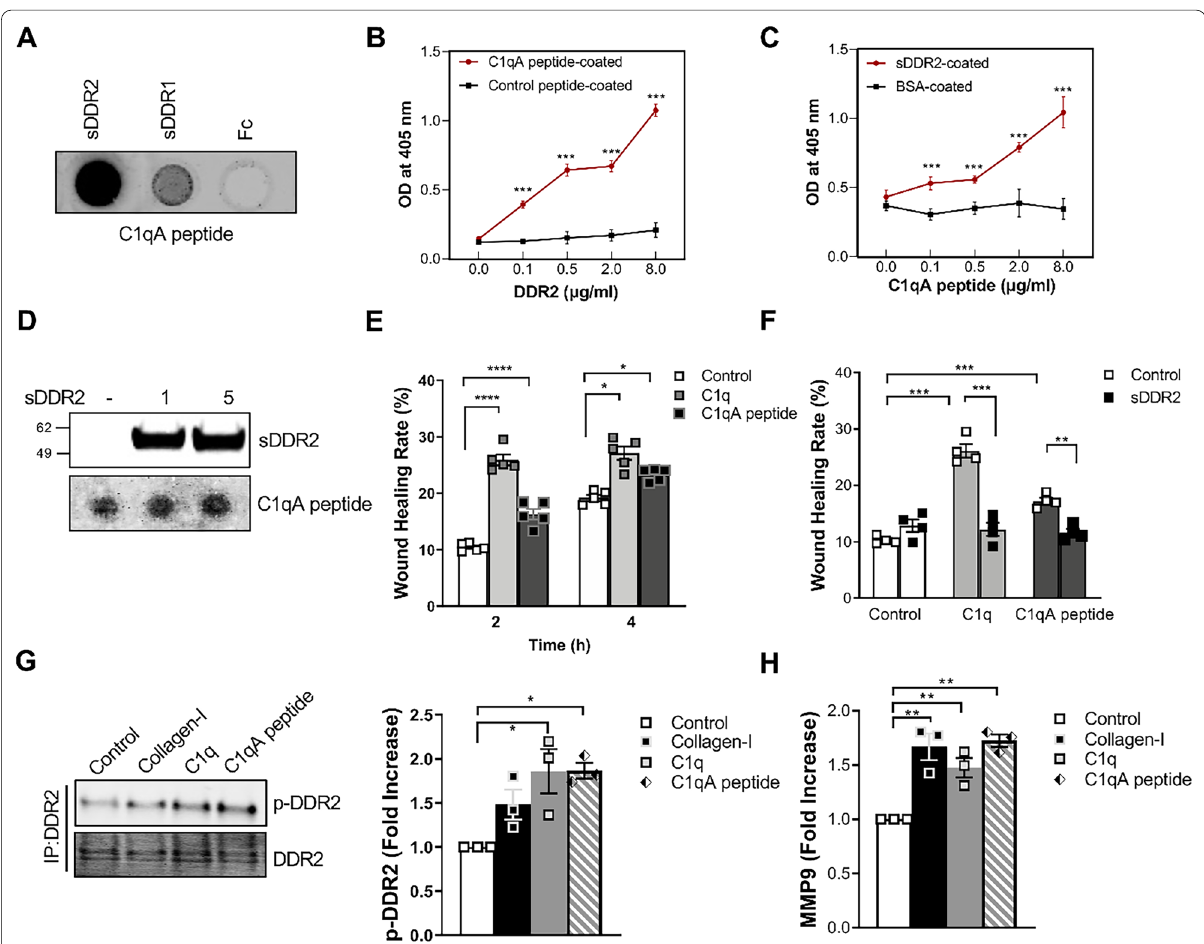
Fig. 5 DDR2 as a receptor for cC1q in HT1080 epithelial cells. A C1q collagen tail peptide (C1qA peptide) binds with DDR2. Recombinant mouse DDR2‑Fc chimera protein (7479‑DR), DDR1‑Fc (6416‑DR), or control Fc (4460‑MG) (20 μg per spot) were blotted onto the nitrocellulose membrane, and then detected using biotinylated C1qA peptide (200 nM). Representative image of three independent experiments. B , C Microtiter plates were immobilized with C1qA peptide or control peptide (8 μg/mL, B ), sDDR2 (2538‑DR), or BSA (8 μg/mL, C ). sDDR2 (2538‑DR; 0, 0.1, 0.5, 2.0 and 8 μg/ mL, B) or C1qA peptide (0, 0.1, 0.5, 2.0 and 8 μg/mL, C ) were added to the plates. Plate‑bound peptides were detected using anti‑His antibody ( B )